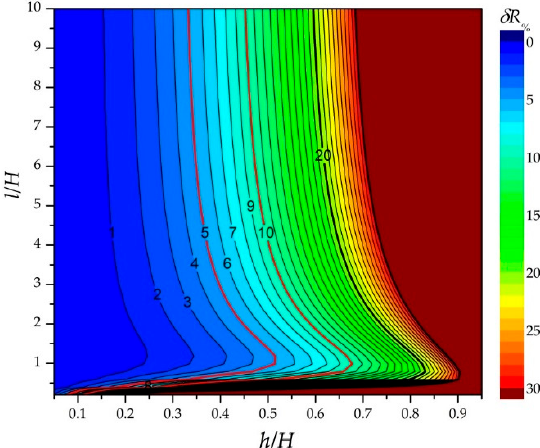
~ calculated using formula (36) for the real